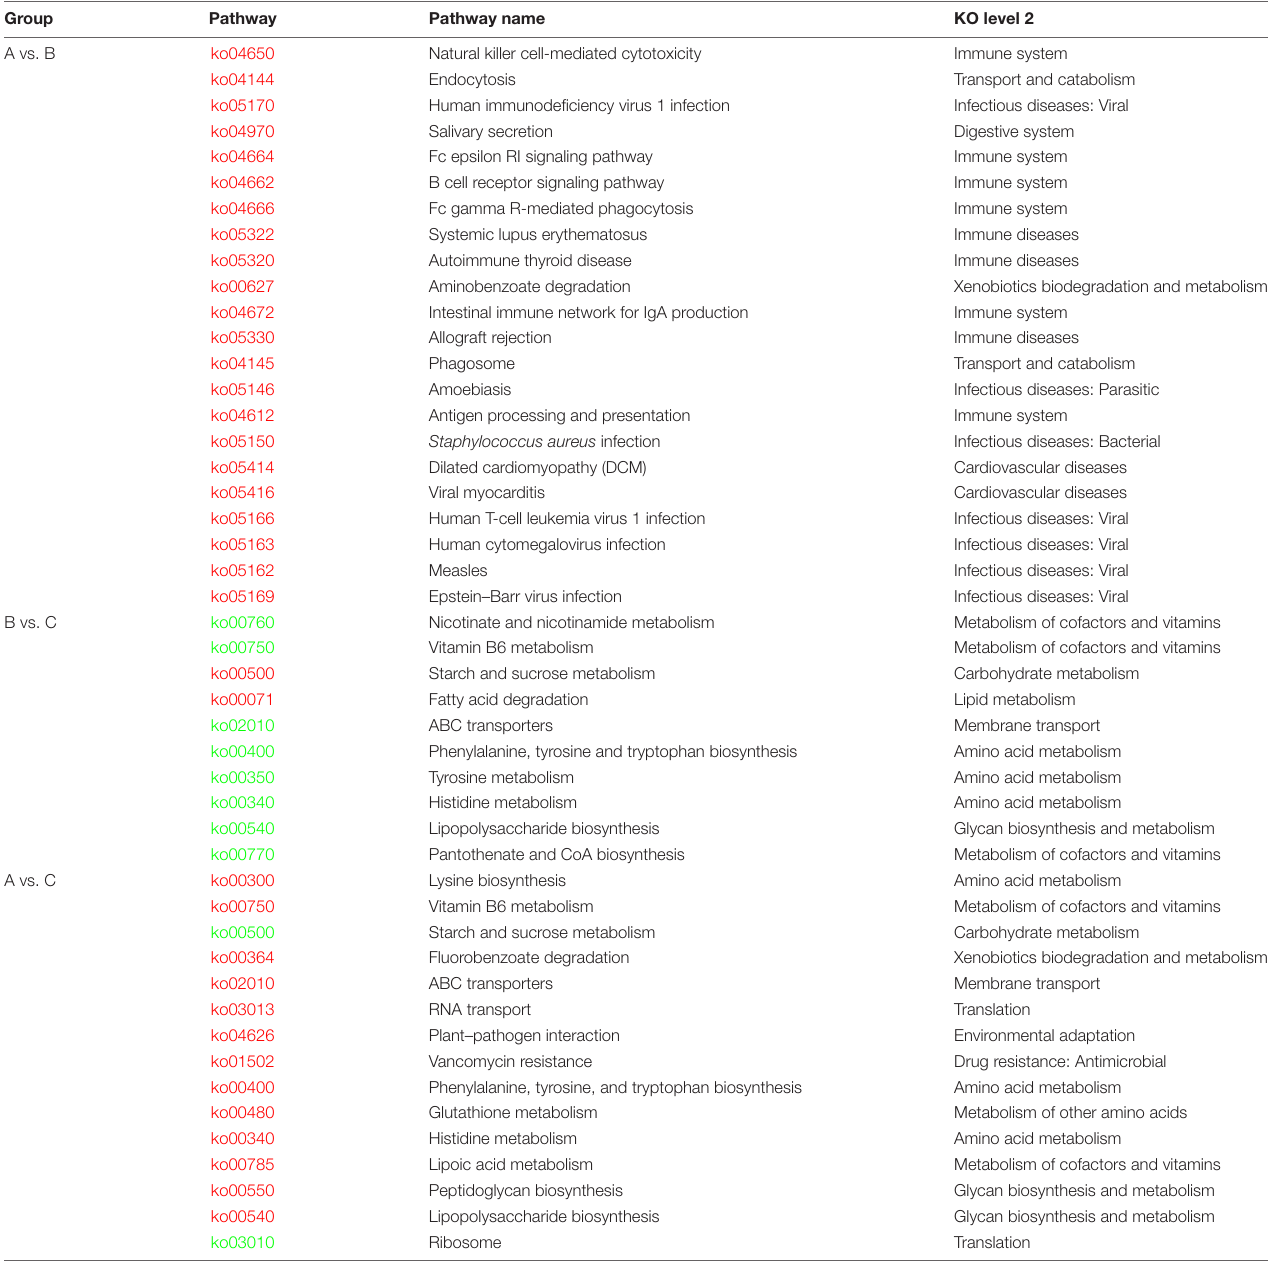
TABLE 2 | Results of KEGG enrichment analysis on significantly changed KOs among groups. Group